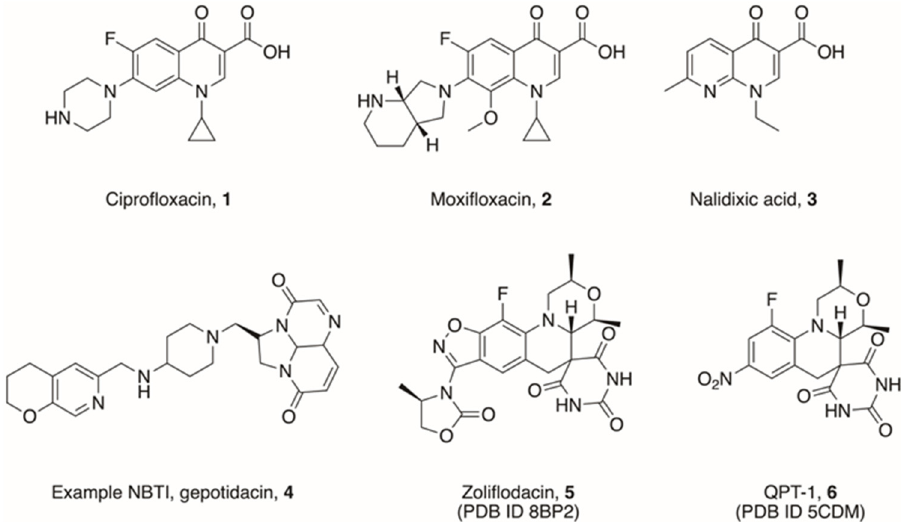
Figure 3. Examples of DNA intercalating drugs. Ciprofloxacin 1 and moxifloxacin 2 are examples of fluoroquinolones (FQ), which are readily used as frontline drugs currently. They are both derivatives of an earlier class of drug, 1,8-naphthyridinones, of which nalidixic acid 3 was the first-in-class. Gepotidacin 4 is an example of a class of topoisomerase inhibitor, which intercalates DNA at an alternative site, leading to a different mechanism of action. Zoliflodacin 5 and QPT-1 6 are examples of spiropyrimidinetriones, found to overlap the FQ site, but act with an alternate mode of inhibition.